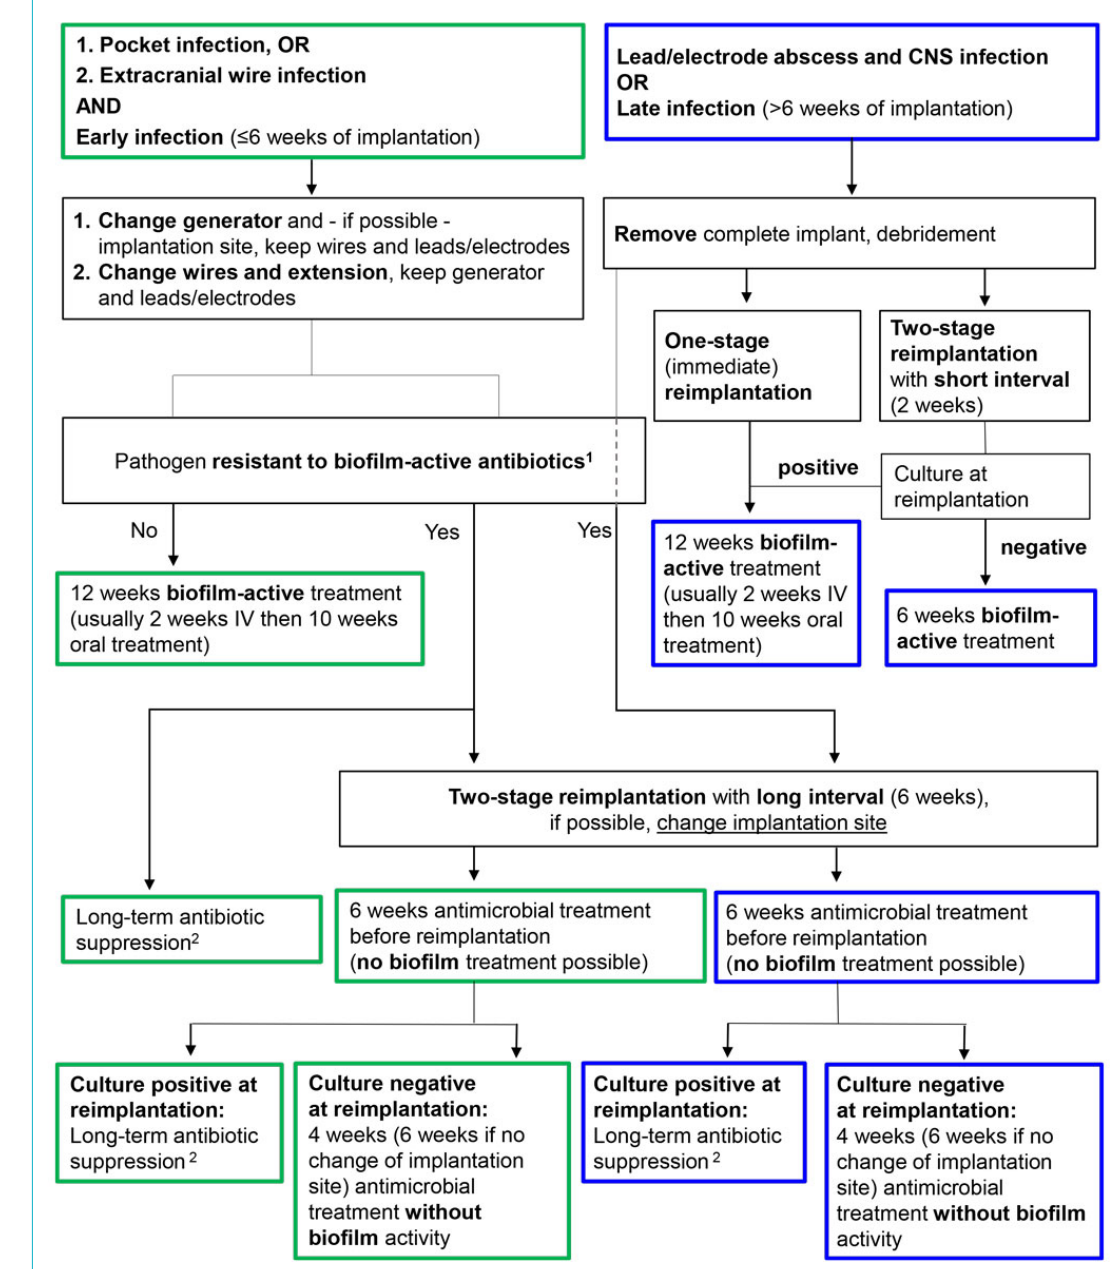
Figure 4: Management algorithm for neurostimulator-associated infections . Antibiotics with biofilm activity: rifampin for staphylococci and Cutibacterium spp.; fluoroquinolones for gram-negative bacilli.CNS = central nervous system; IV = intravenousBlue frame = intradural treat- ment; green frame = extradural treatment 1 Rifampin-resistant staphylococci, quinolone-resistant gram-negative bacilli and Candida spp. 2 An- tibiotics for long-term antimicrobial suppression treatment are cotrimoxazole and doxycycline for intradural infections and cotrimoxazole, doxy- cycline and clindamycin for extradural